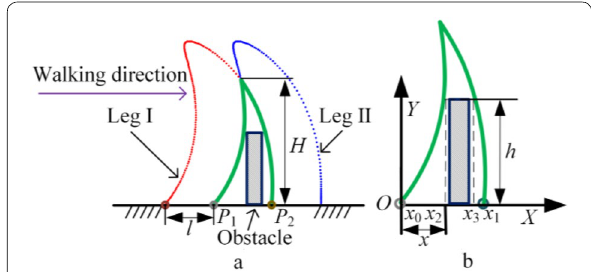
Figure 7 Obstacle-surmounting process